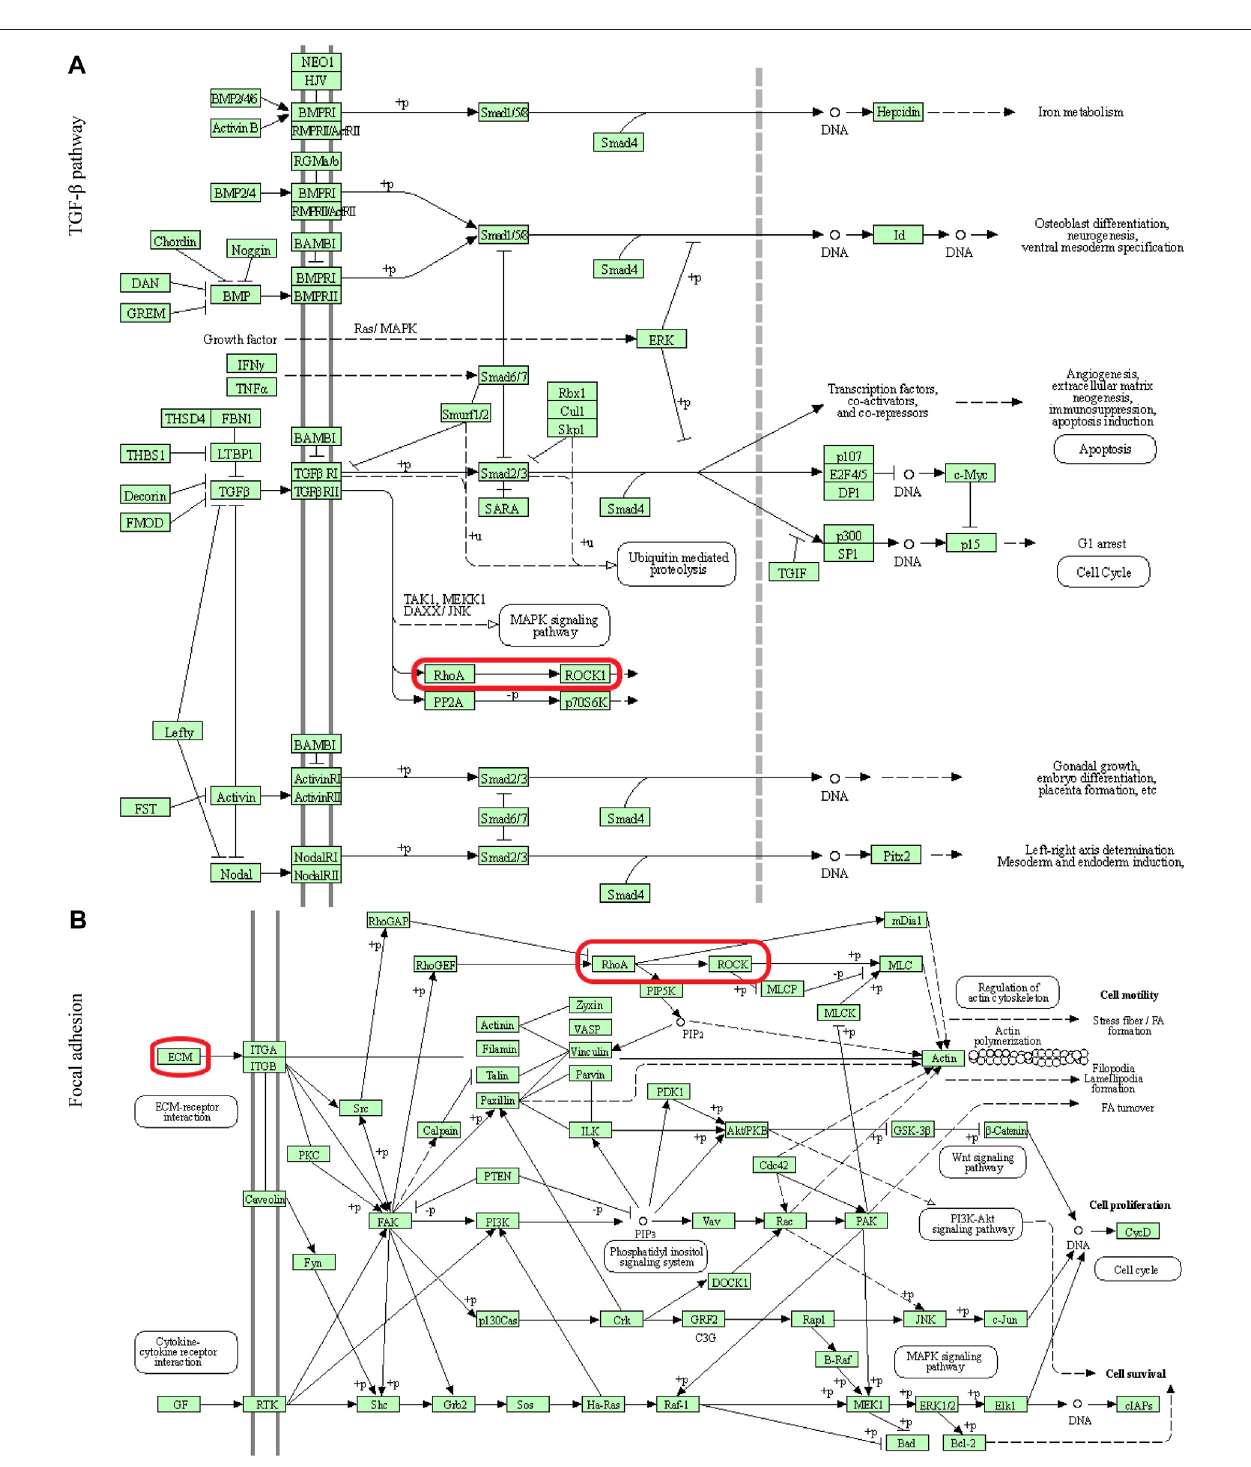
FIGURE 5 | Visualization of the TGF- β pathway and Focal adhesion (A) The TGF- β pathway (B) Focal adhesion. The red box indicated that these two signaling pathways passed through RhoA/ROCK.